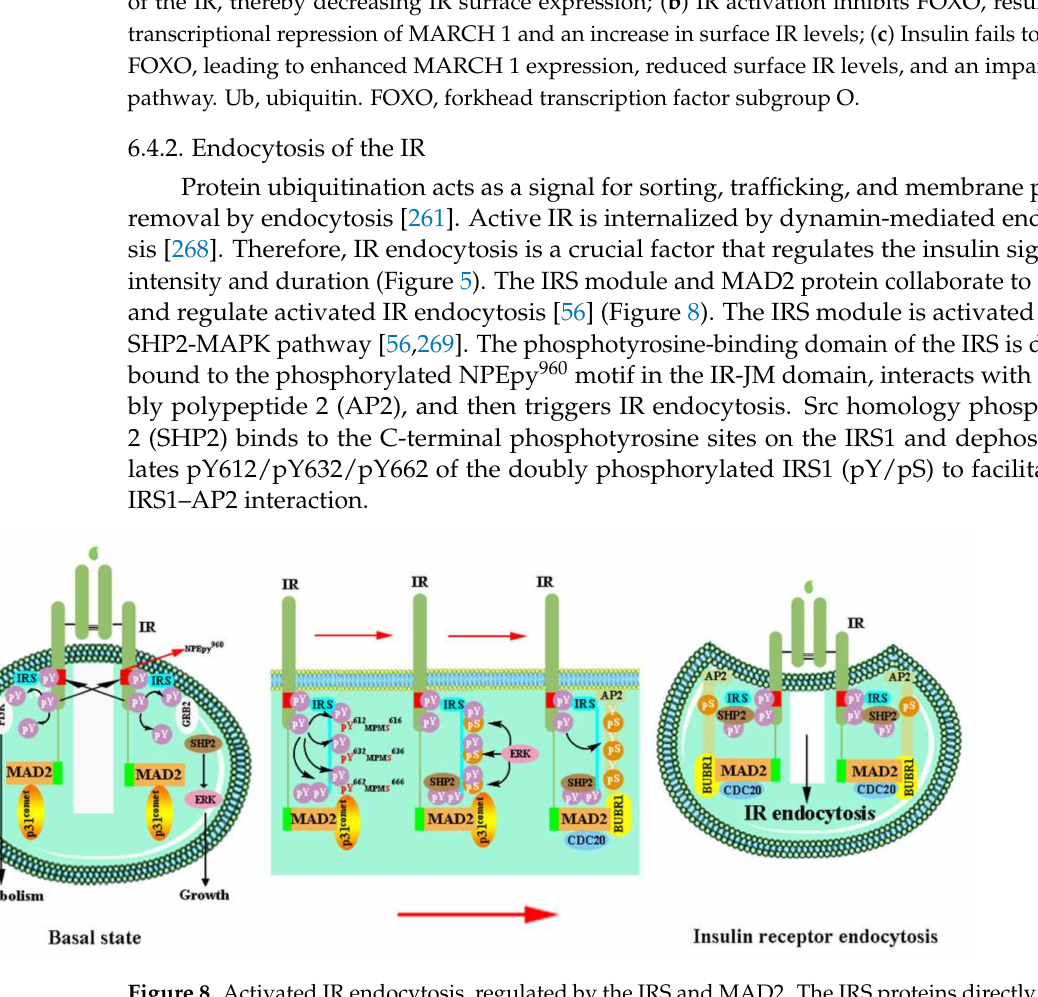
Figure 8. Activated IR endocytosis, regulated by the IRS and MAD2. The IRS proteins directly bind to the IR-JM domain and interact with AP2; p31 comet suppresses the interaction of BUBR1-CDC20-AP2 and IR-bound MAD2, thus interfering with IR endocytosis in the basal state. The connection of BUBR1-CDC20-AP2 and IR-MAD2 causes IR endocytosis. SHP2, Src homology phosphatase 2; ERK, extracellular-signal-regulated kinase; AP2, assembly polypeptide 2; Y612/Y632/Y662, IR tyrosine phosphorylates the YXX Φ motifs on the IRS1. S616/S636/S666, activate ERK phosphorylates on the